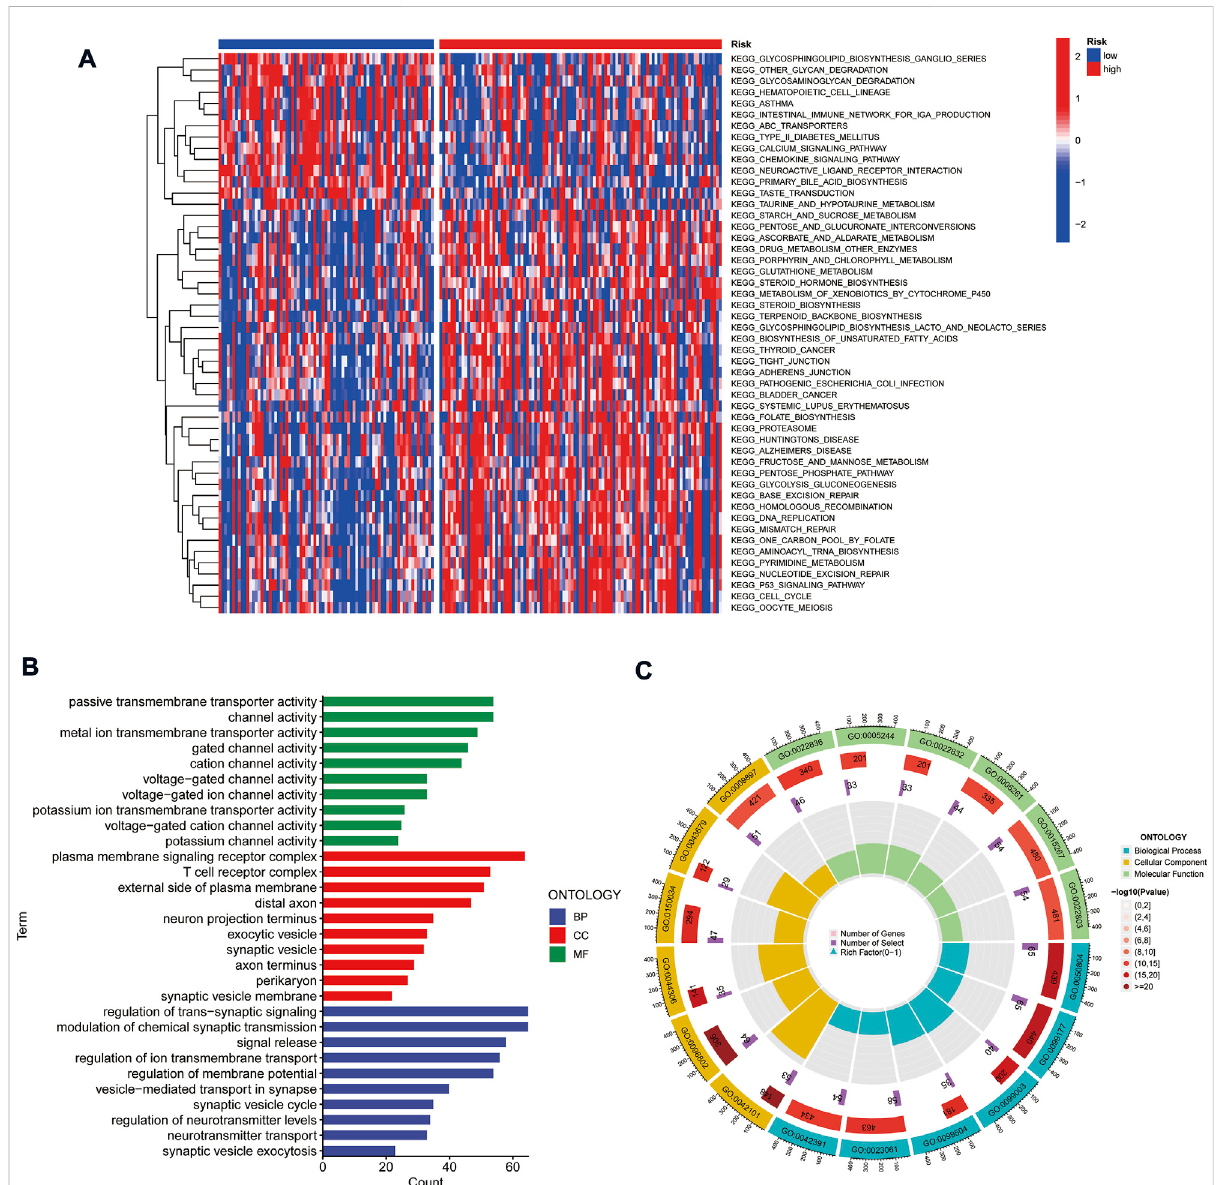
FIGURE 6 Genesetvariationanalysisandgeneontologyanalysis. (A) Heatmaphighlightingthedifferencesinfunctionalpathwaysinhigh-riskandlow-risk groups. (B,C) Exploring the enrichment of differentially expressed genes between high- and low-risk groups in terms of biological function by GO